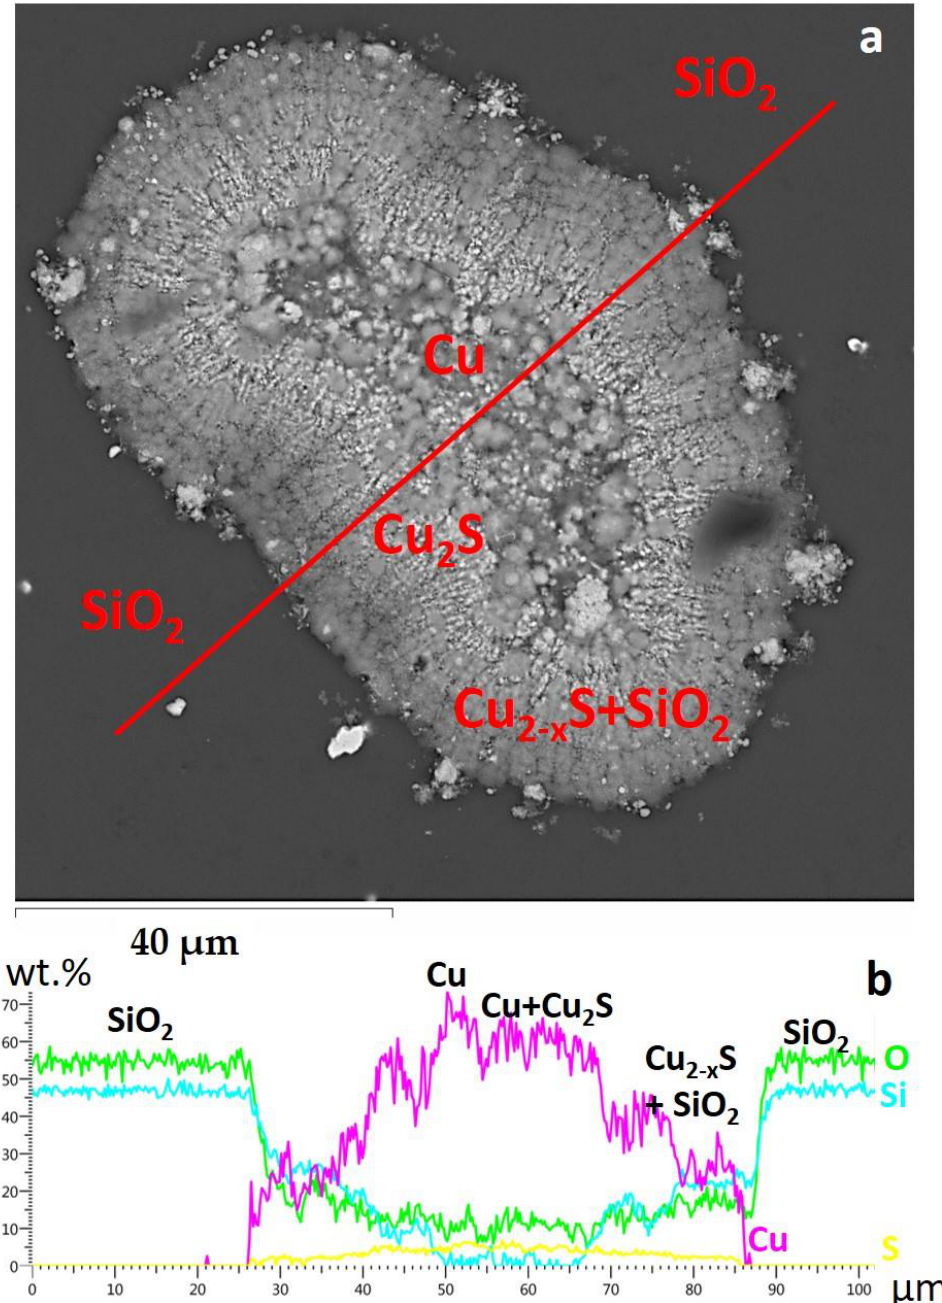
Figure 14. Native copper and dendrites of copper sulphides are present in quartz ovoid ( a ). Concentrations of the elements Si, O, Cu, and S ( b ) (in wt.%) are shown along the scanning line of the fragment agate No. 7 (Figure 4f). ( a ) SEM micrograph.